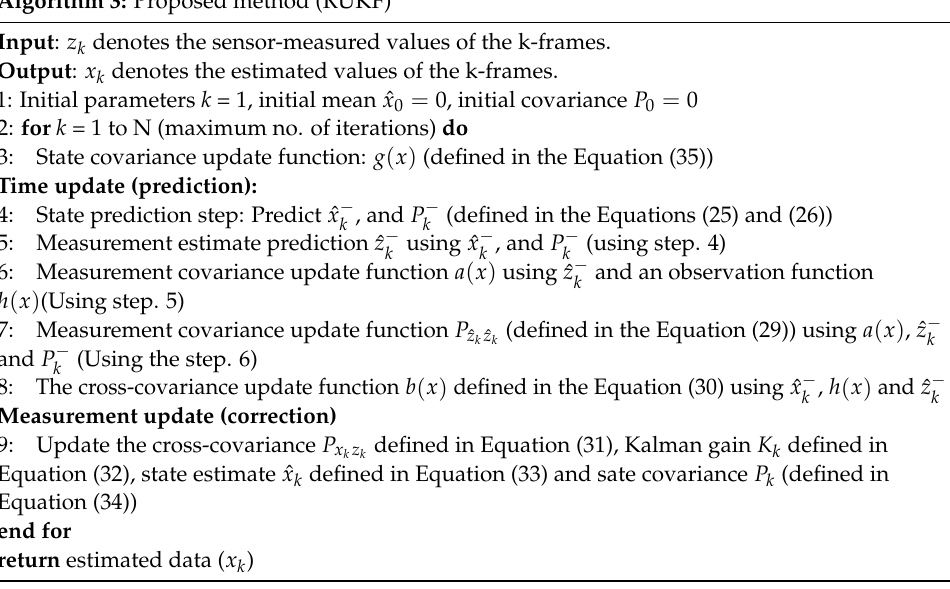
Algorithm 3: Proposed method